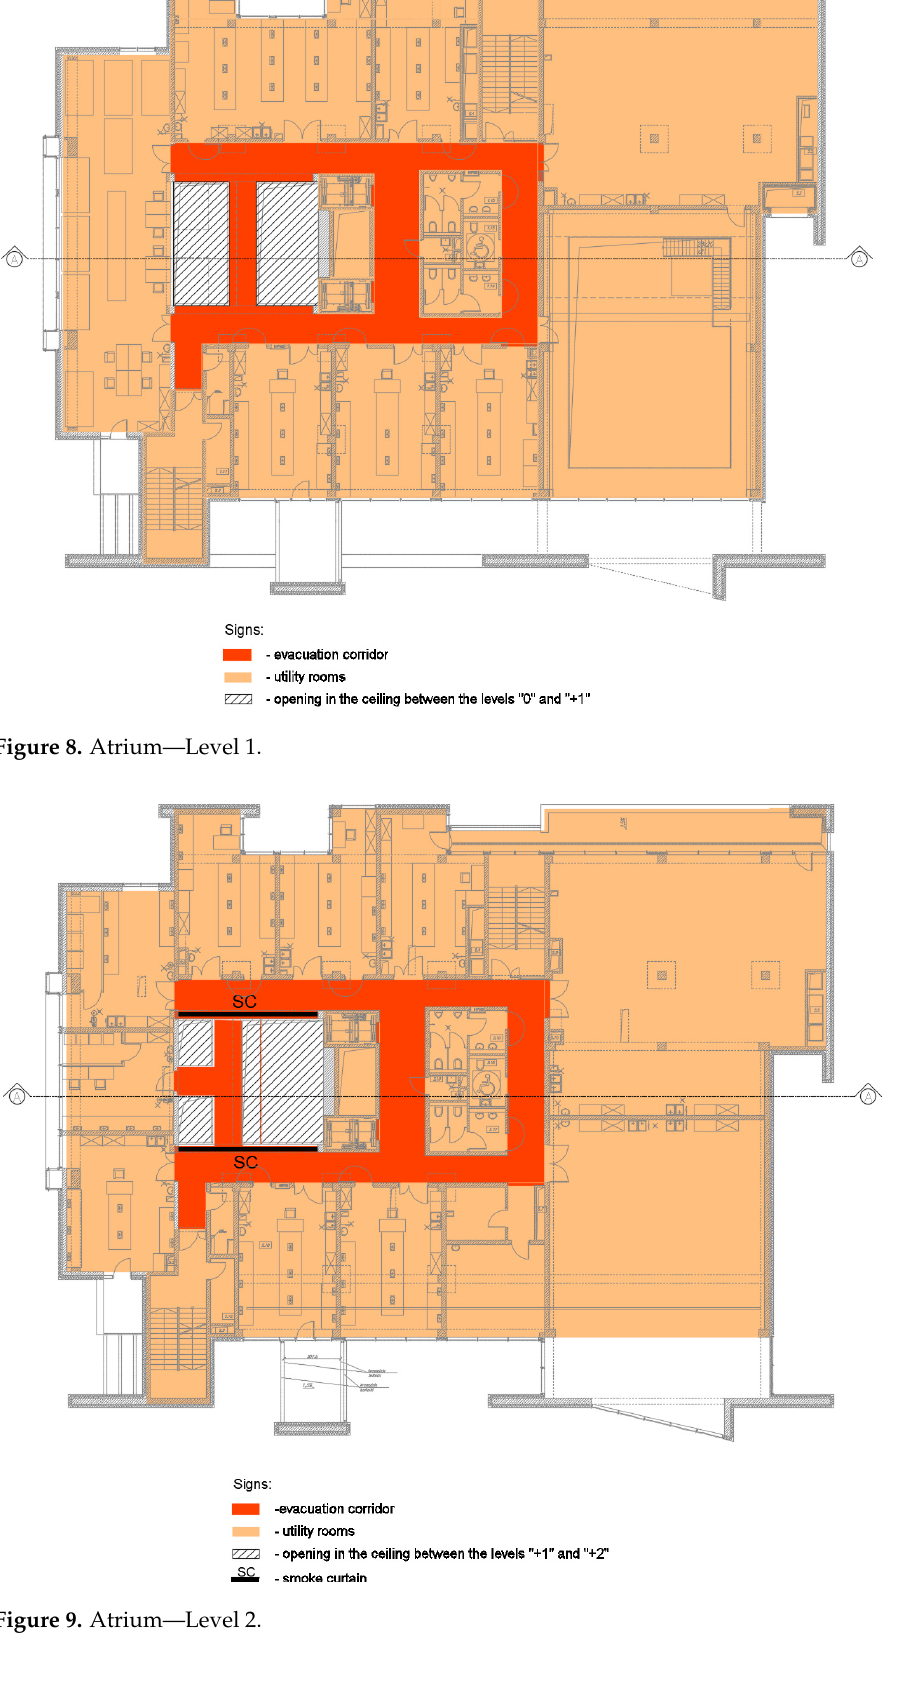
Figure 9. Atrium—Level 2.